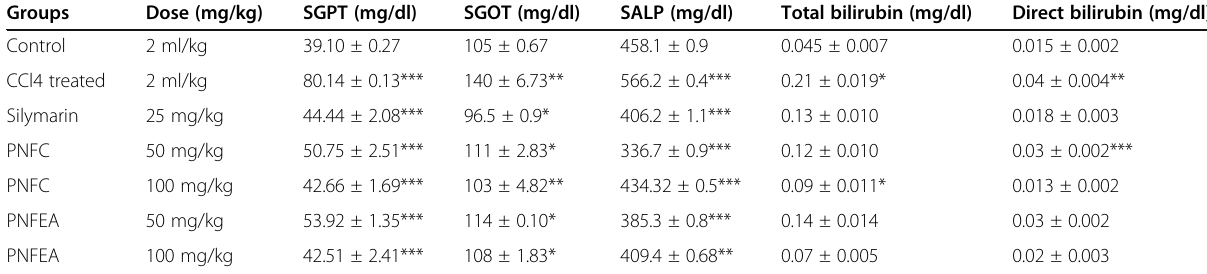
Table 2 Effect of PNFC and PNFEA fractions on SGPT, SGOT, SALP, and total and direct bilirubin in CCl 4 -induced rats Groups